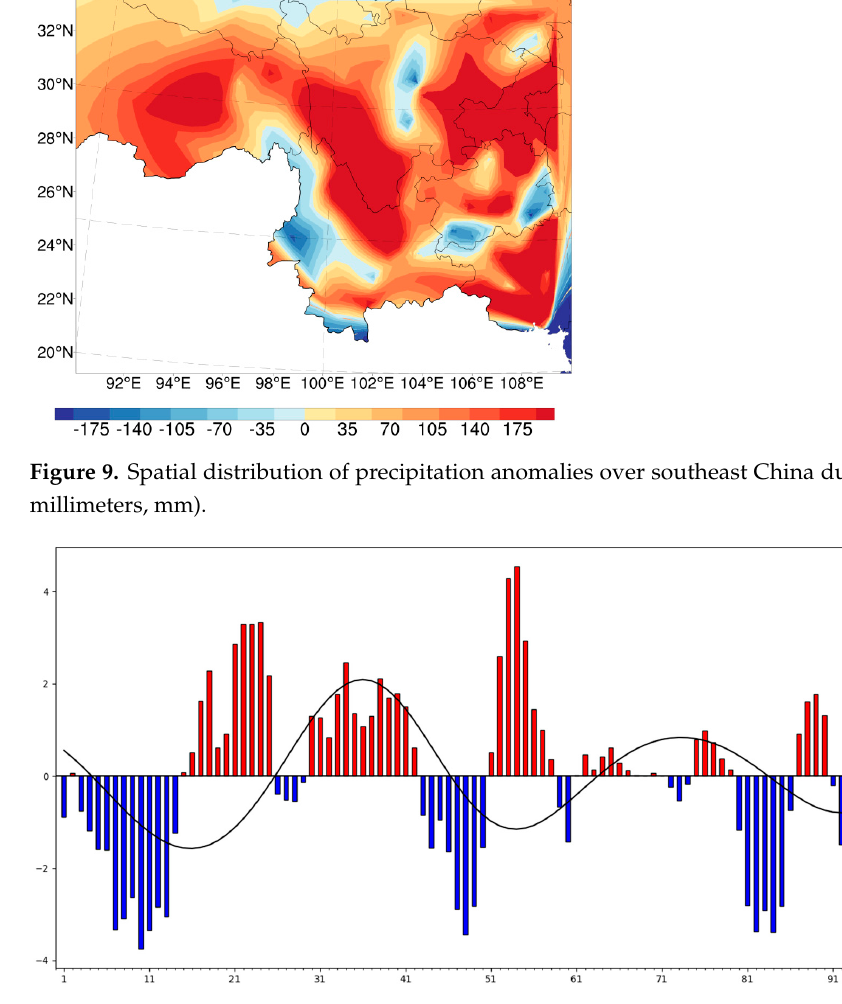
Figure 11. Time-longitude profile of OLR along 105° to 130° E in 1998. In order to explore the relationship between the ISO of the EASM and precipitation evolution in southwest China, the two 30–60 days ISO cycles of the EASM in 1998 were divided into 6 phases, respectively (Figure 12). In phase 1 of the first cycle, as a whole, southwest China was a negative anomaly region, with low precipitation (Figure 13). In phase 2, the central and western regions of Guangxi and its surroundings turned into positive anomaly regions, with an increase in precipitation, and the rest of the regions were negative precipitation anomaly regions. In phase 3, the positive precipitation anomaly region extended westward to Yunnan and the eastern region of Tibet, and a small range of positive precipitation anomaly regions also appeared in eastern Sichuan. In phase 4, the precipitation in the central and western regions of Guangxi weakened, the high precipitation area in Yunnan shifted to the westward, eastern Sichuan to Chongqing showed a clear high precipitation area and precipitation in eastern Tibet also increased significantly. In phase 5, the precipitation in the southwest of China was gen- erally higher, there were still maximum centers of precipitation in southern Yunnan and southwestern Guangxi, maximum centers of precipitation in the Sichuan and Chongqing area developed westward to the central and western regions of Sichuan, with an obvious increase in precipitation. In phase 6, the precipitation in southwest China weakened,